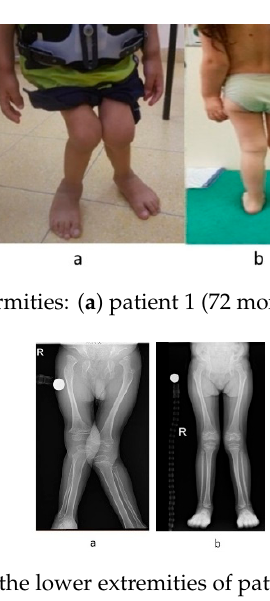
Picture 3. Radiographic pictures of the lower extremities of patients 1 and 2: (a) patient 1 (84 months); ( b ) patient 2 (48 months) .